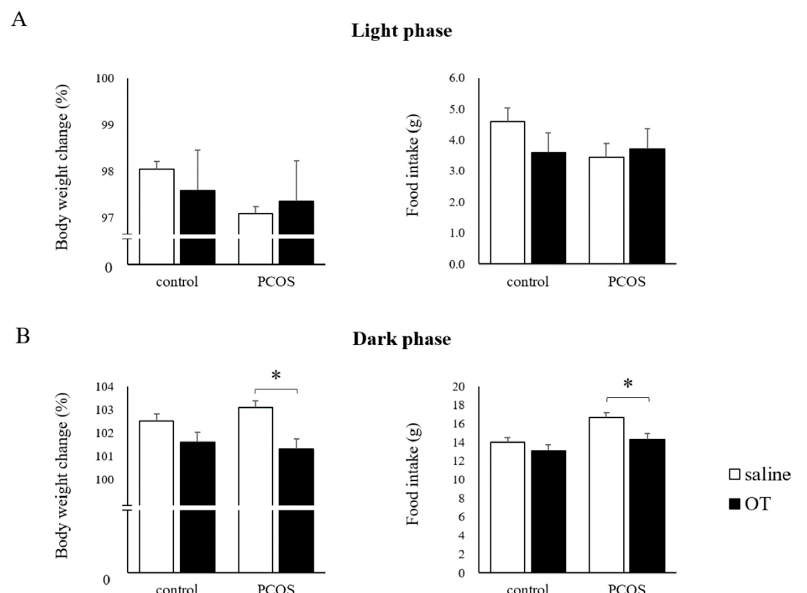
Figure 4. The body weight change and food intake after acute saline ( □ ) or oxytocin (OT; ■ ) administration during the light phase ( A ) or the dark phase ( B ) in the PCOS and Control groups. Data are expressed as the means ± SEM. * p < 0.05.